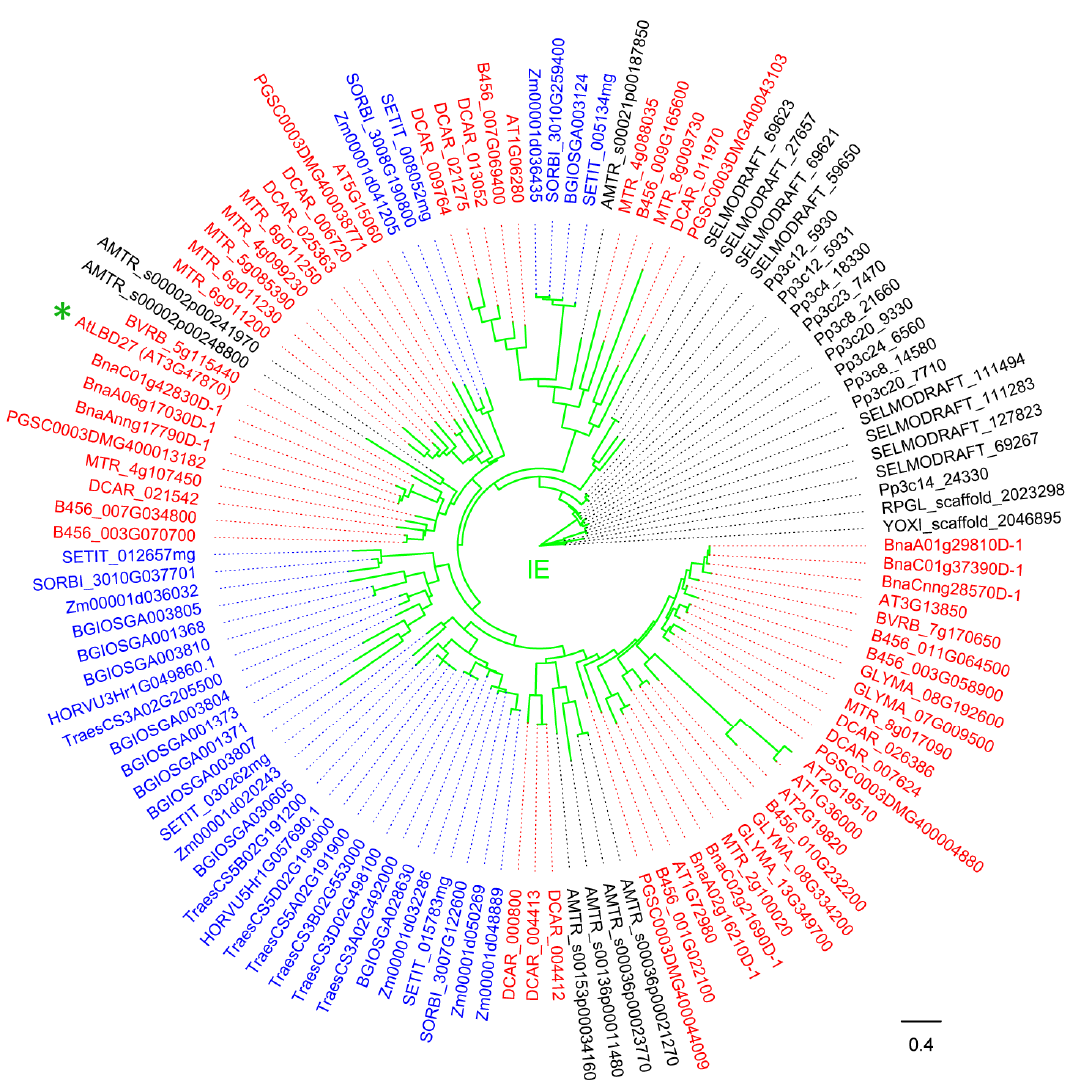
Figure 7. Phylogeny of LBD proteins from Class IE in 18 species. This phylogeny was reconstructed using Class IE LBD proteins identified in Figure 1 and according to the same method described in Figure 1 legend. “*” means functionally characterized LBD protein in Table 2 (Gene ID is in brackets for LBD proteins of 18 species, species name is in square brackets for LBD proteins of other species). LBD proteins of eudicots, monocots, and other plant species are marked in red, blue and black, respectively. Branch color corresponds to that in Figure